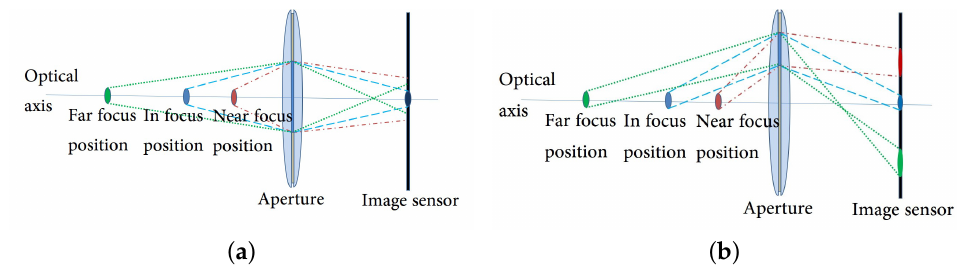
Figure 1. Imaging system with single aperture: ( a ) paths of light rays in a conventional optical system; ( b ) paths of light rays in a single off-axis aperture system.